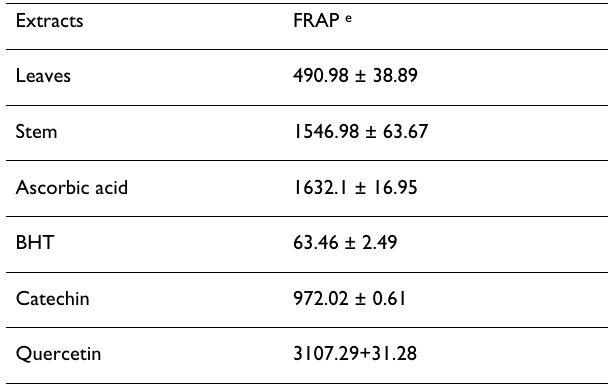
e Expressed in units of μ mol Fe